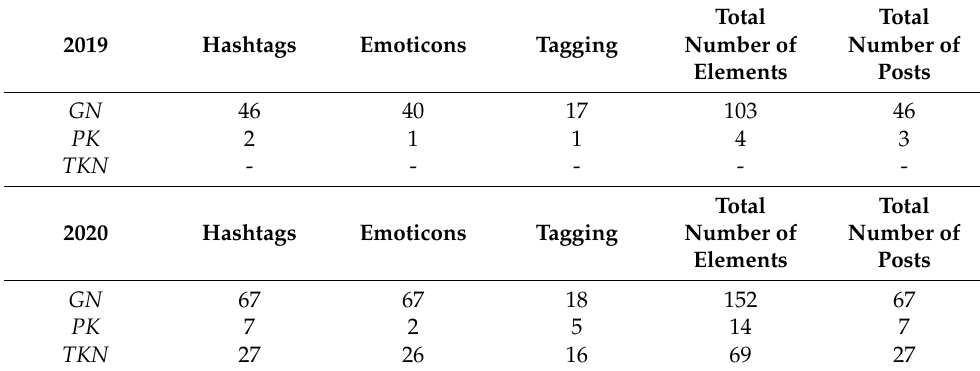
Table 5. Components of the post content on the Instagram profiles of the selected Catholic weeklies